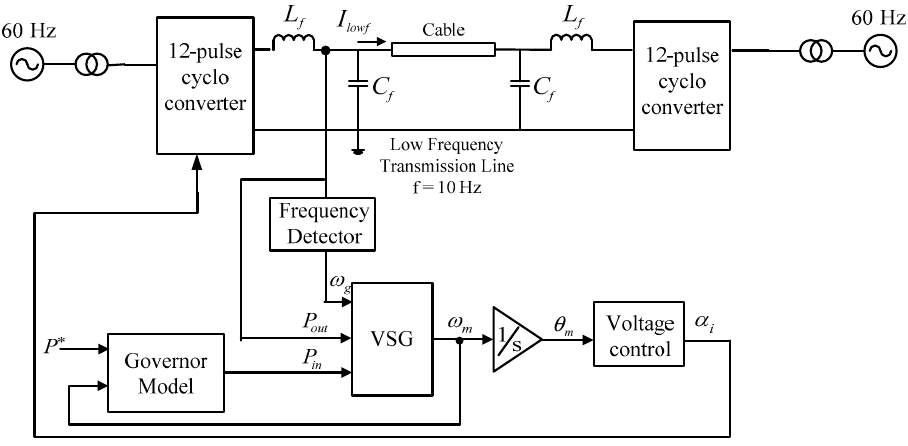
Figure 10. Block diagram of the VSG control scheme for LFAC.